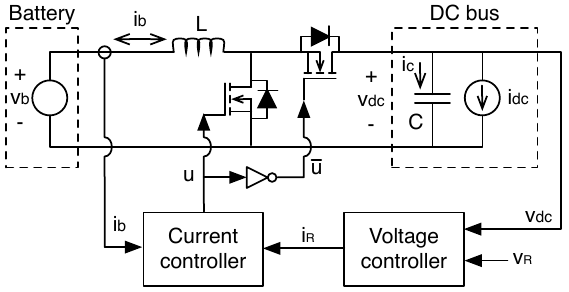
Figure 2. Structure of a cascade control of the